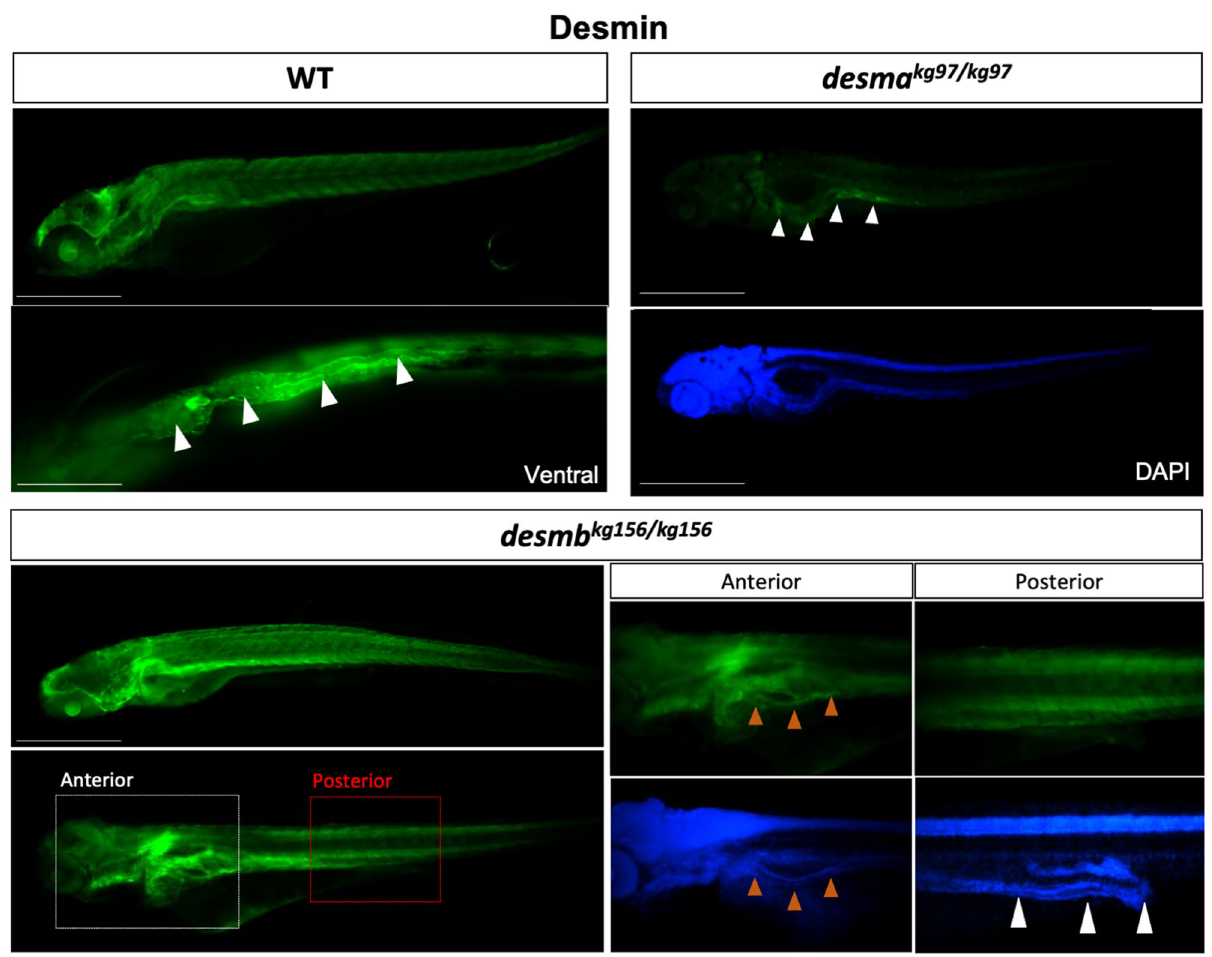
Figure 3. Desmin protein expression in 96 hpf embryos. Whole mount immunofluorescence staining of desmin with anti-desmin polyclonal antibody recognizing both Desma and Desmb, in wild-type and mutant 96 hpf embryos. Left upper panel is lateral view of a WT embryo with anterior to left, dorsal to top, beneath is ventral view with anterior to left, white arrowheads indicate the gut. Right upper panels are lateral views of desma kg97/kg97 with anterior to left, dorsal to top. Lower panel shows desmb kg156/kg156 embryos with anterior to left, dorsal to top. Scale bar: 500 µm. Boxes with dashed lines delineate areas that were zoomed and focused on anterior and posterior segments of the intestine as shown in lower right panels, orange arrowheads indicate anterior intestine, white arrowheads show middle and posterior segments of the